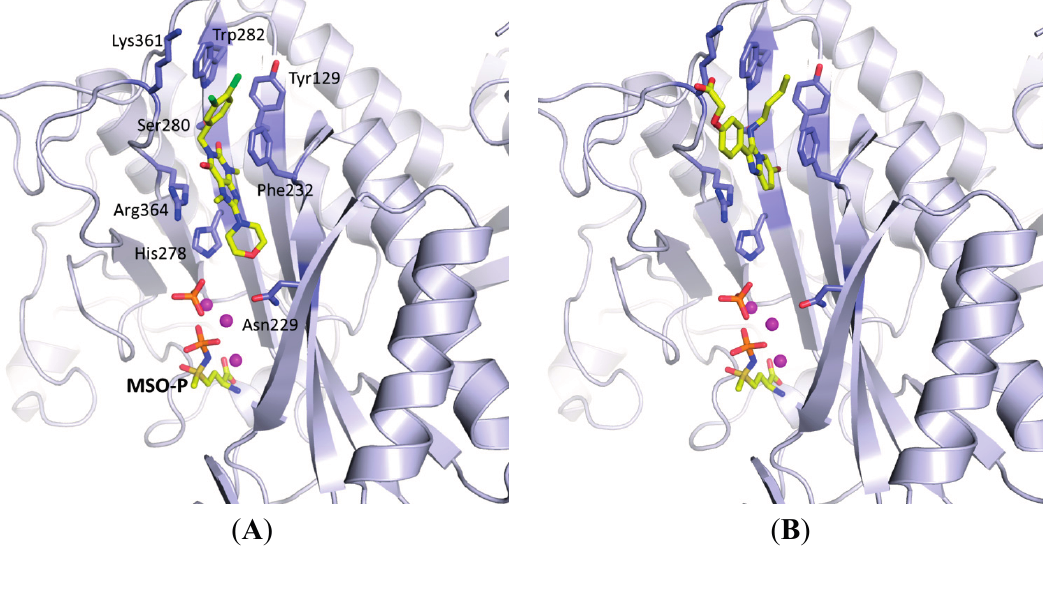
Figure 9. ( A ) X-ray structure of Mt GS (blue carbons) bound to purine analogue 23 (yellow carbons), MSO-P, phosphate and magnesium ions (PDB entry 2WHI [20]). ( B )